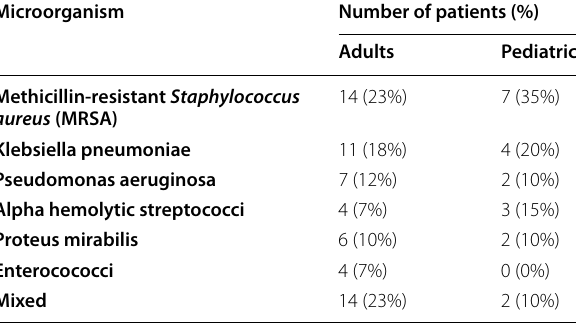
Table 3 Pathogens of the DNSI